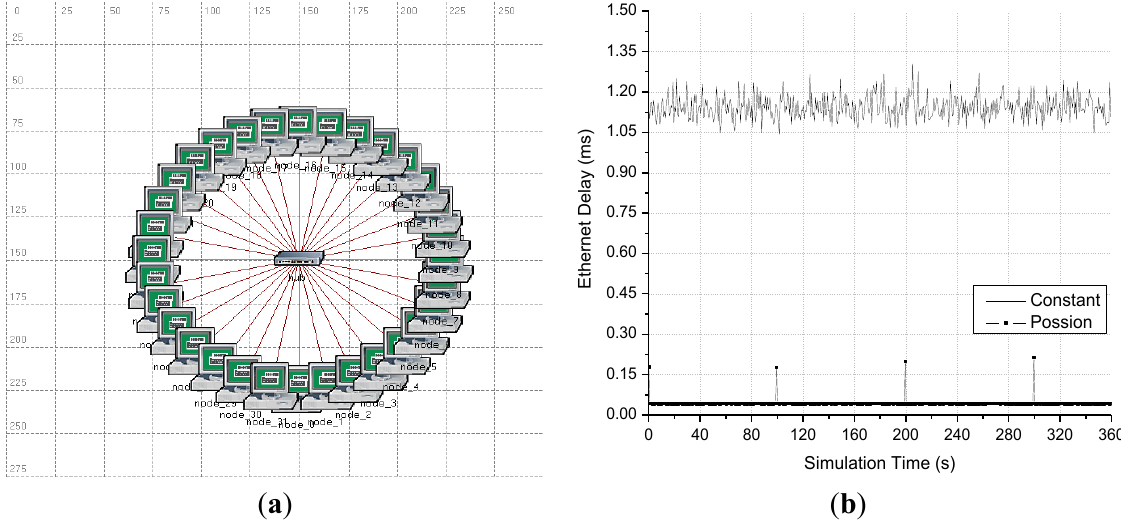
Figure 7. Simulation study system by using OPNET: ( a ) simulation topology; and ( b ) simulation